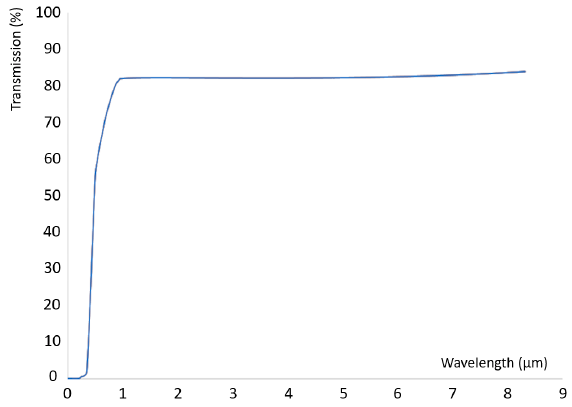
Figure 17. The calculated transmission spectrum of polycrystalline PMN-PT. Table 5. The calculated and measured transmission and absorbance of a 1.5 mm thick polycrystalline PMN-PT slab for three different wavelengths.